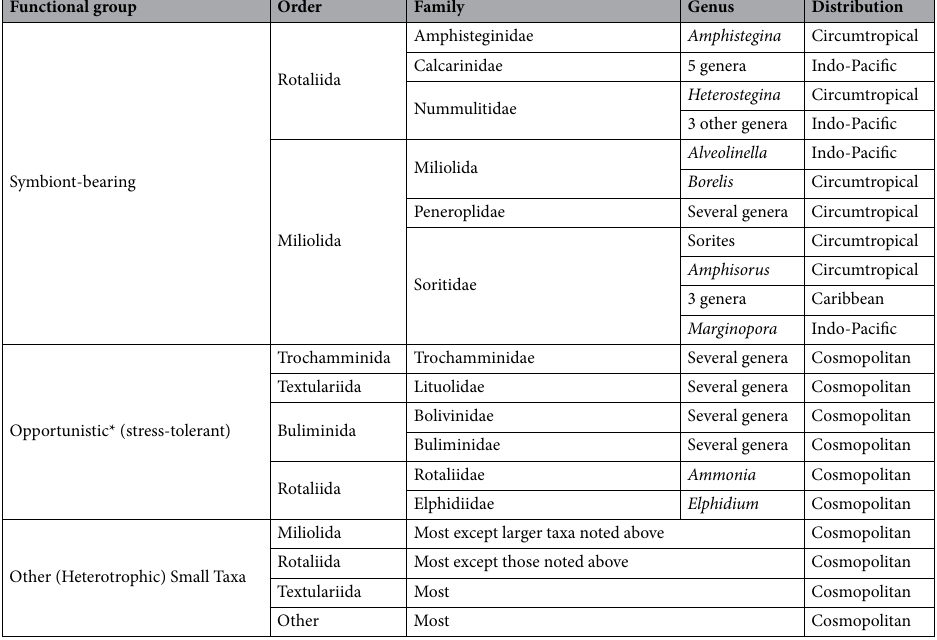
Table 5. Functional Groups assigned to benthic foraminifera used in coral reef assessment 11,29 . *Full range of opportunistic genera under local conditions is not well